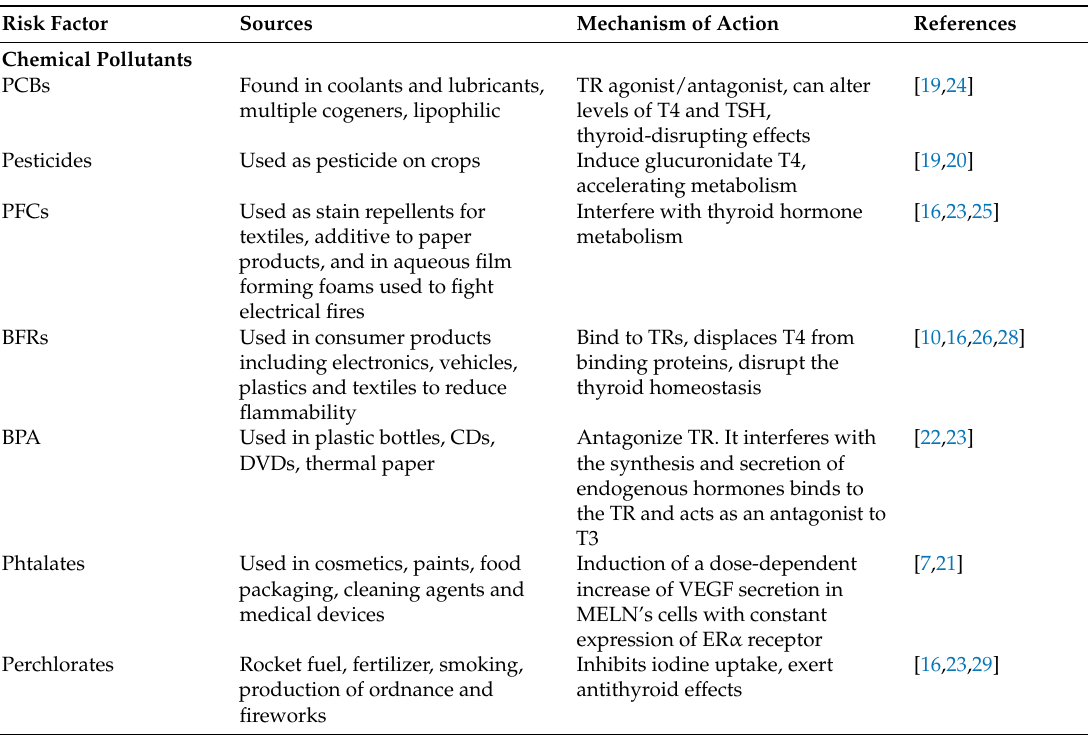
Table 1. Environmental factors and thyroid cancer